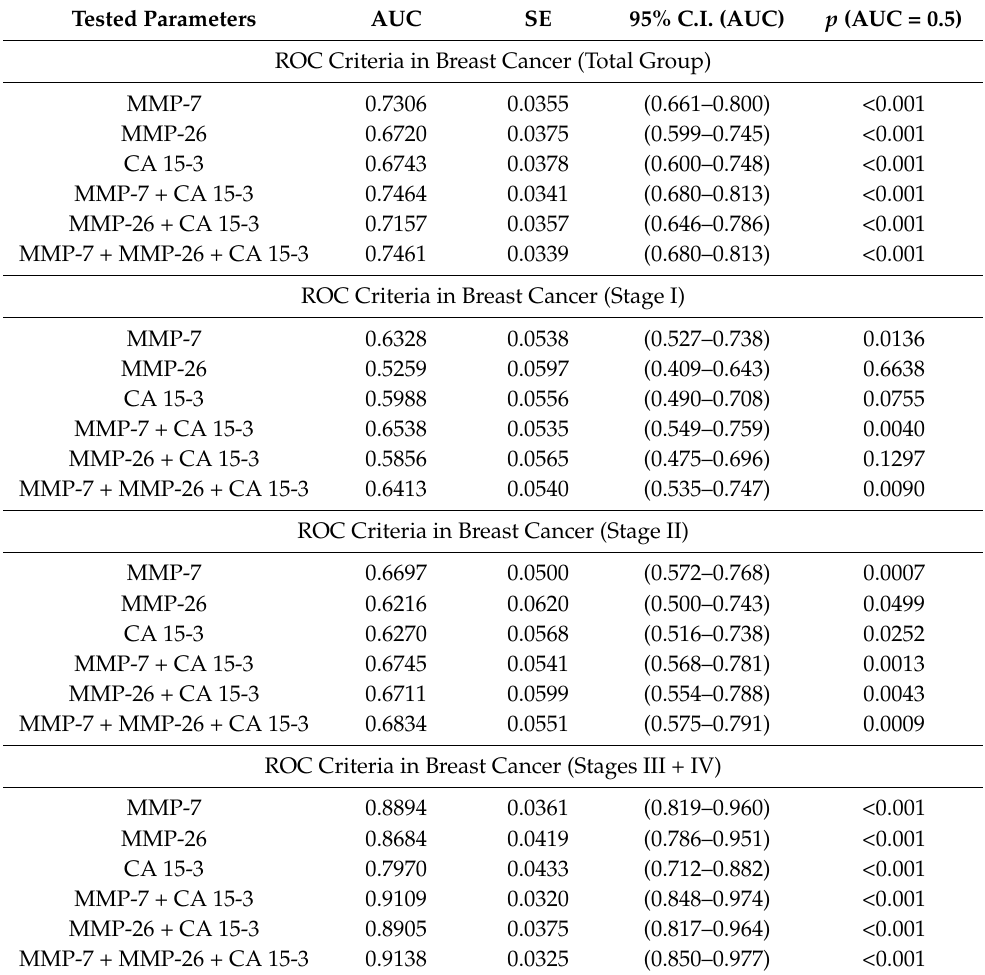
Table 3. Diagnostic criteria of ROC curve for tested parameters in